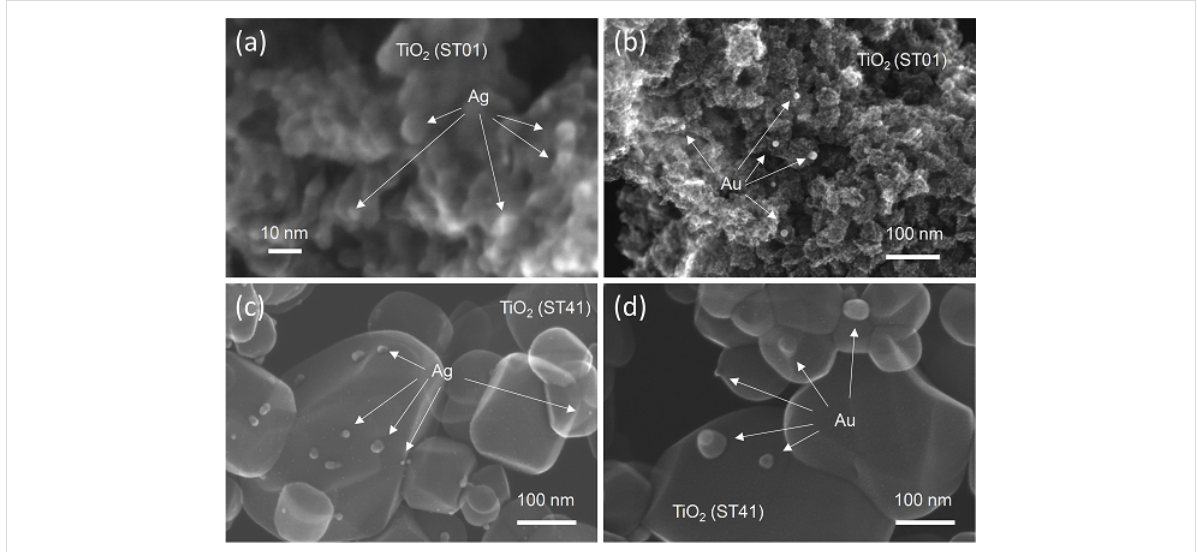
Figure 1: STEM images of modified titania samples: (a) Ag/TiO 2 (ST01), (b) Au/TiO 2 (ST01), (c) Ag/TiO 2 (ST41) and (d) Au/TiO 2 (ST41).